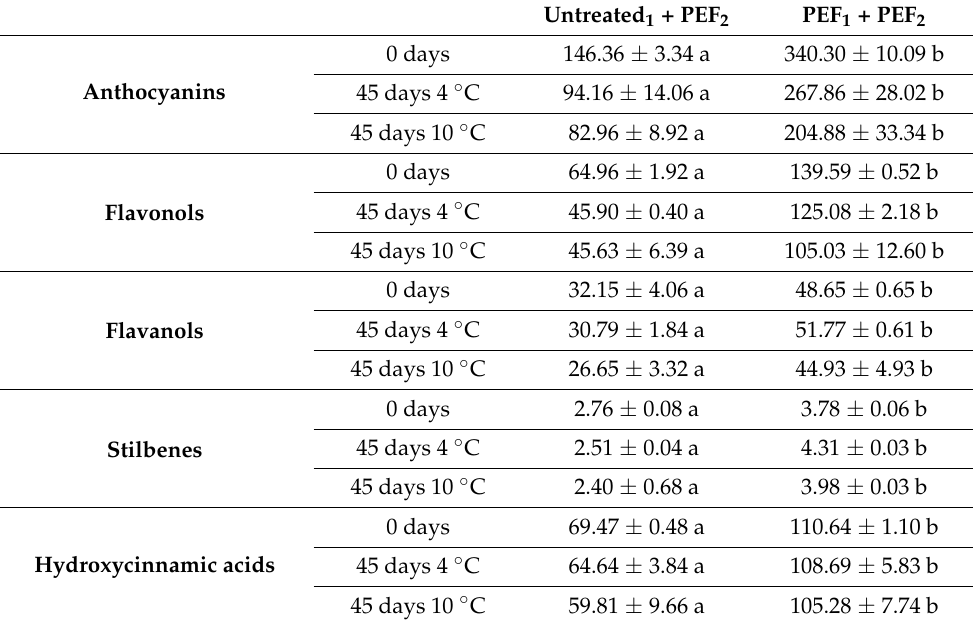
Table 4. Total content of anthocyanins, flavanols, flavonols, stilbenes, and hydroxycinnamic acids (mg/L) after 45 days of storing at 4 and 10 ◦ C in grape juices obtained from untreated and PEF-treated grapes and subsequently decontaminated by